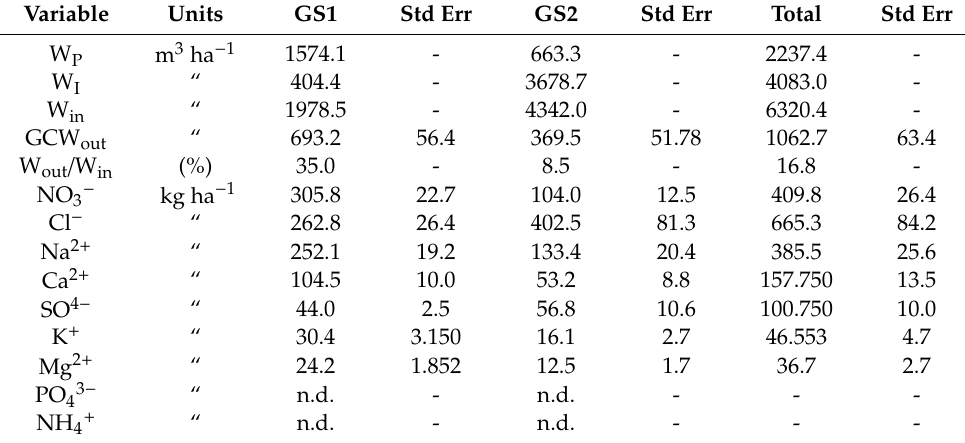
Table 1. Average values of water inflow (rains (W P ) and irrigation (W I ) volumes per unit area), water outflow (drainage) and solute leaching detected in the two consecutive growing cycles (GS1 and GS2) and all the year-round (GS1 + GS2).